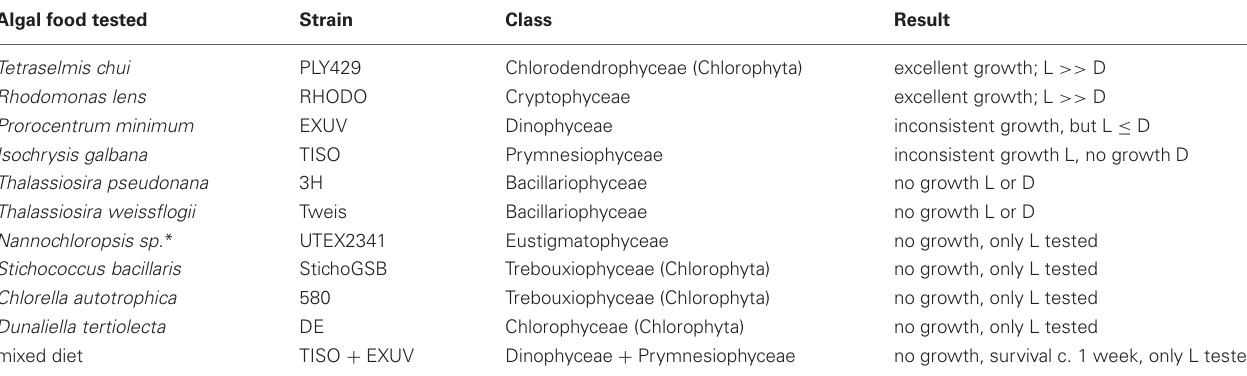
Table 2 | Ability of different algae to support growth in the oligotrich ciliate Strombidium rassoulzadegani . Algal food